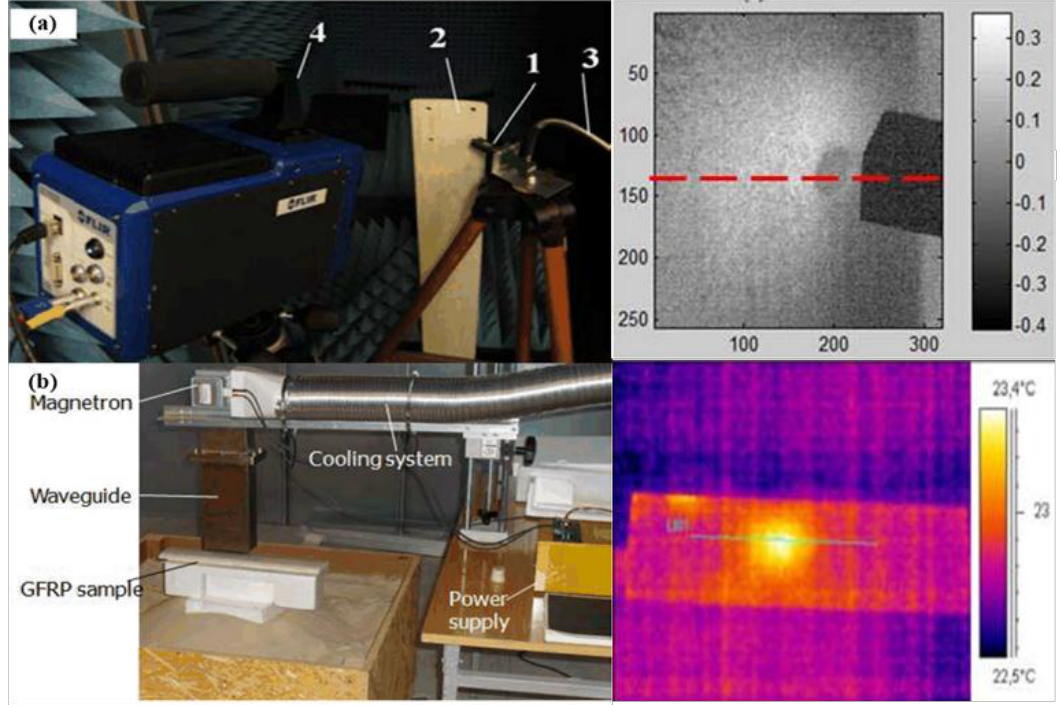
Figure 10. MWT setup in Newcastle University ( a ) and West Pomeranian University of Technology ( b ) [57]. Reprinted/reproduced with permission from IEEE.